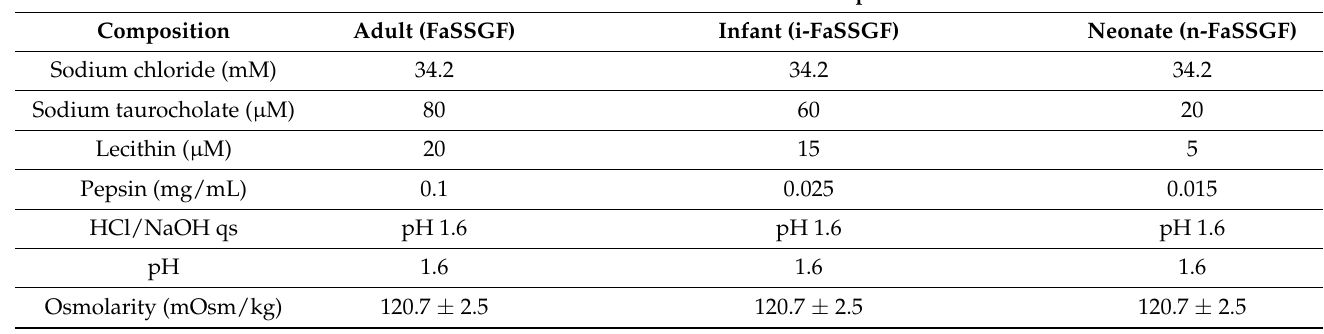
Table 2. Composition of adult and paediatric biorelevant media used in solubility and dissolution experiments [21,22]. FaSSGF = Fasted-state Simulated Gastric Fluid, FeSSGF = Fed-state Simulated Gastric Fluid, FaSSIF = Fasted-state Simulated Intestinal Fluid, FeSSIF = Fed-state Simulated Intestinal Fluid, i = infant, n = neonate, c = cow-based milk formula, s = soy-based milk formula, and b = breast